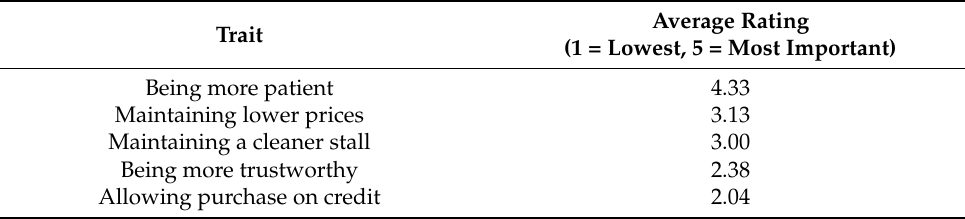
Table 6. Results of vendor ranking exercise for “ways to attract and keep customers” ( n =